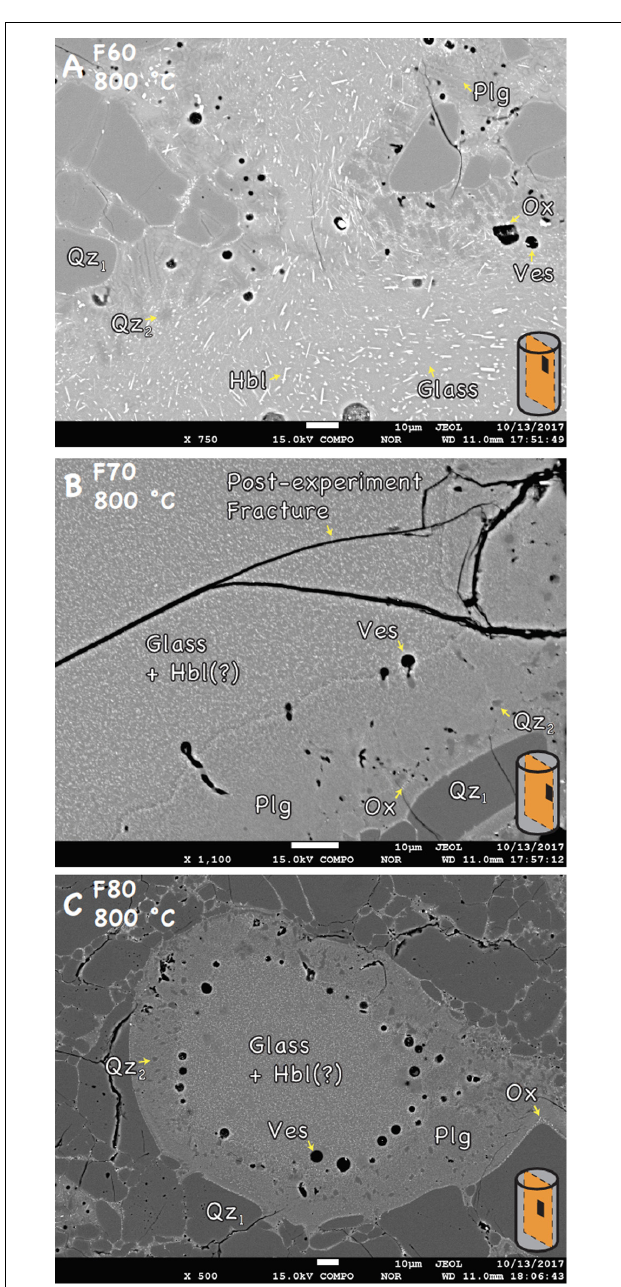
FIGURE 6 | FEG-probe-based BSE images of selected portions within the central polished sections of: (A) F60, (B) F70, and (C) F80 at 800 ◦ C. See acronyms from Figure 5 , plus Ox = oxide (white round phase). Sketches of cylindrical samples (light gray) show the location of the sample portion (black rectangles) inspected in the sample central section (orange